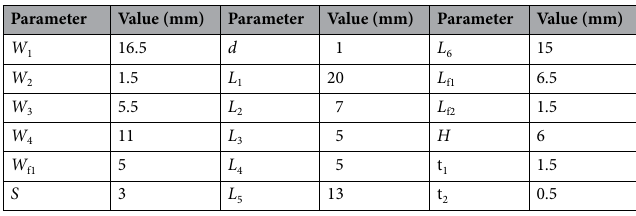
Table 1. Final geometrical parameters of the